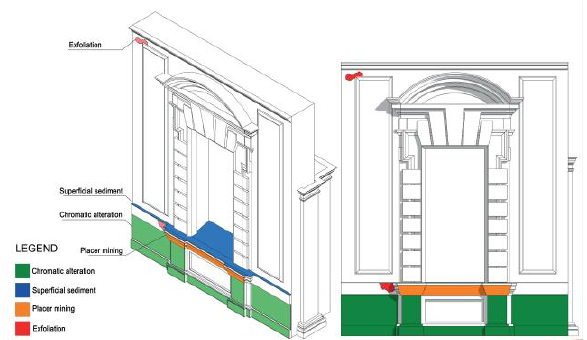
Figure 13. 3D modeling of the decays using specific